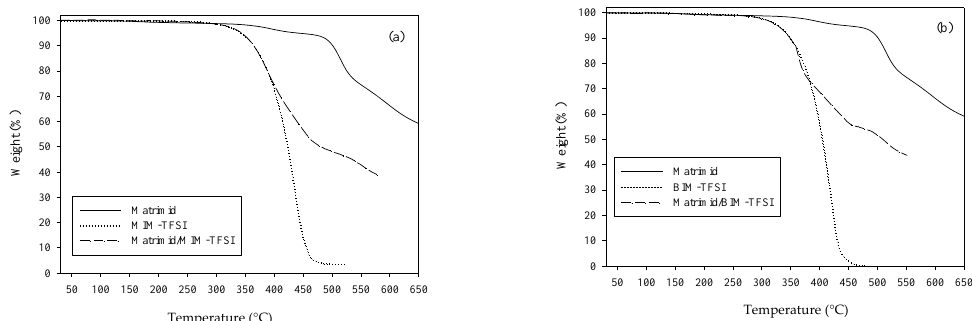
Figure 8. TGA curves of the composite Matrimid ® /PIL membranes based on: ( a ) MIM-TFSI and ( b ) BIM-TFSI.